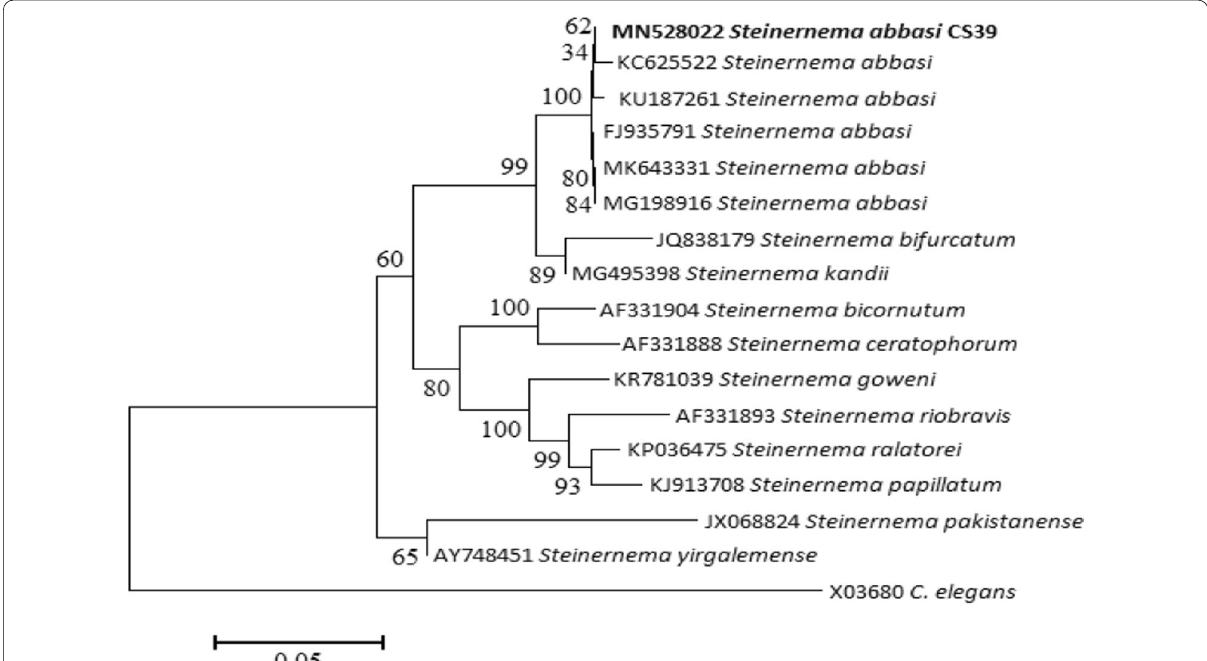
Fig. 2 Phylogenetic relationships in the “bicornutum” group of Steinernema based on analysis of D2D3 regions. Caenorhabditis elegans was used as outgroup taxa. The percentage of replicate trees in which the associated taxa clustered together in the bootstrap test (10,000 replicates) is shown next to the branches. Branch lengths indicate evolutionary distances and are expressed in the units of number of base differences per site